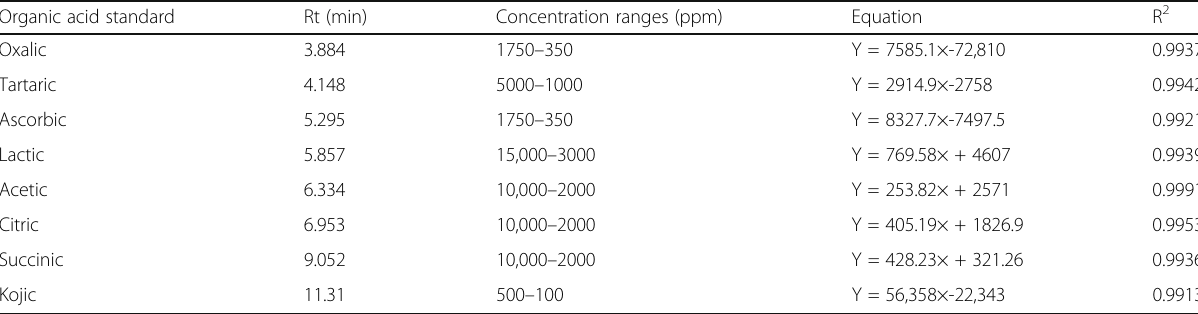
Table 2 Retention time, concentration ranges of lineal response and correlation coefficient for standard organic acids Organic acid